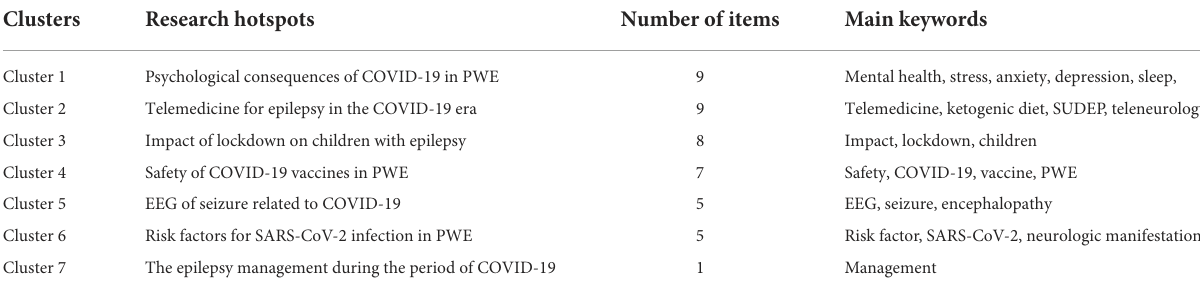
TABLE 4 The clusters organized by keyword co-occurrence